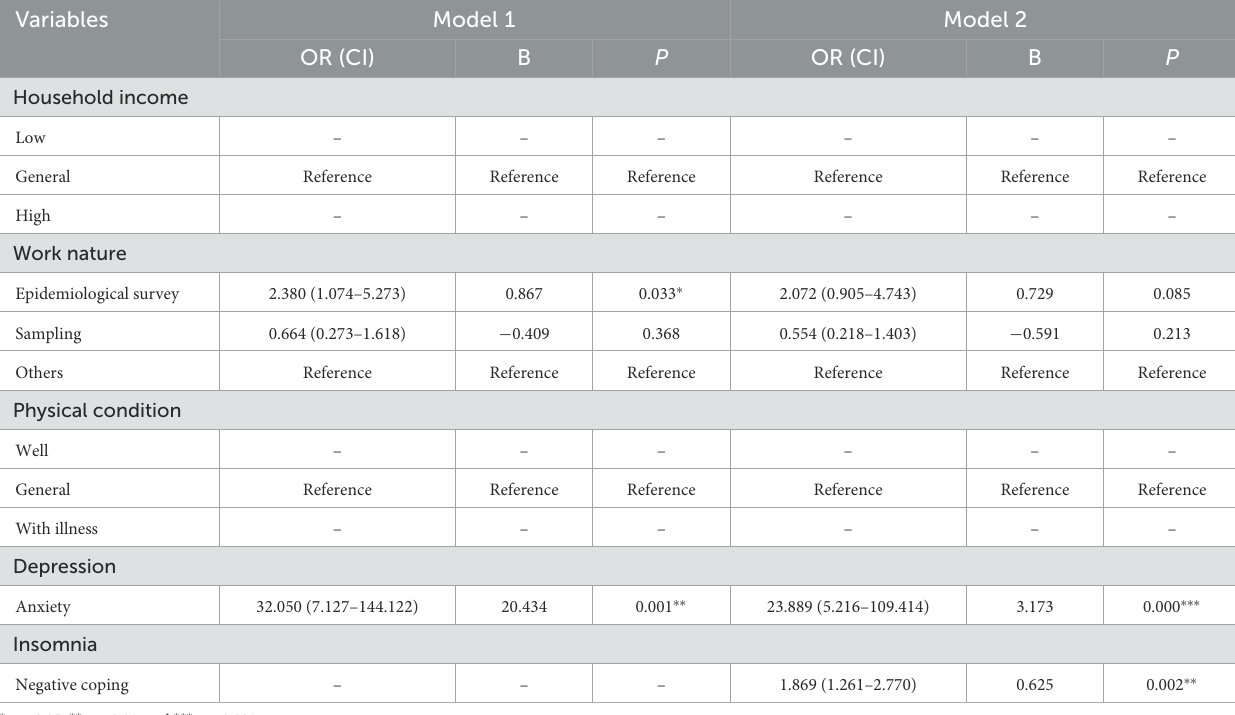
TABLE 3 Hierarchical logistic analysis of burnout and significant factors